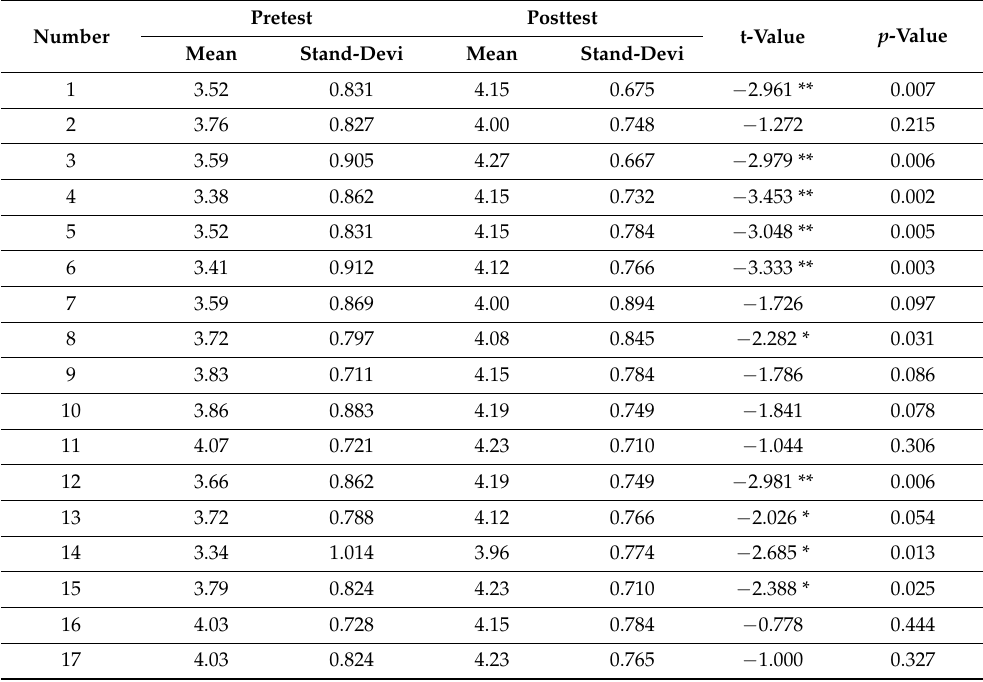
Table 9. Mean, the standard deviation of the scores, and t -test result of the questionnaire survey using AMVR system regarding the Dornier 228 (n =